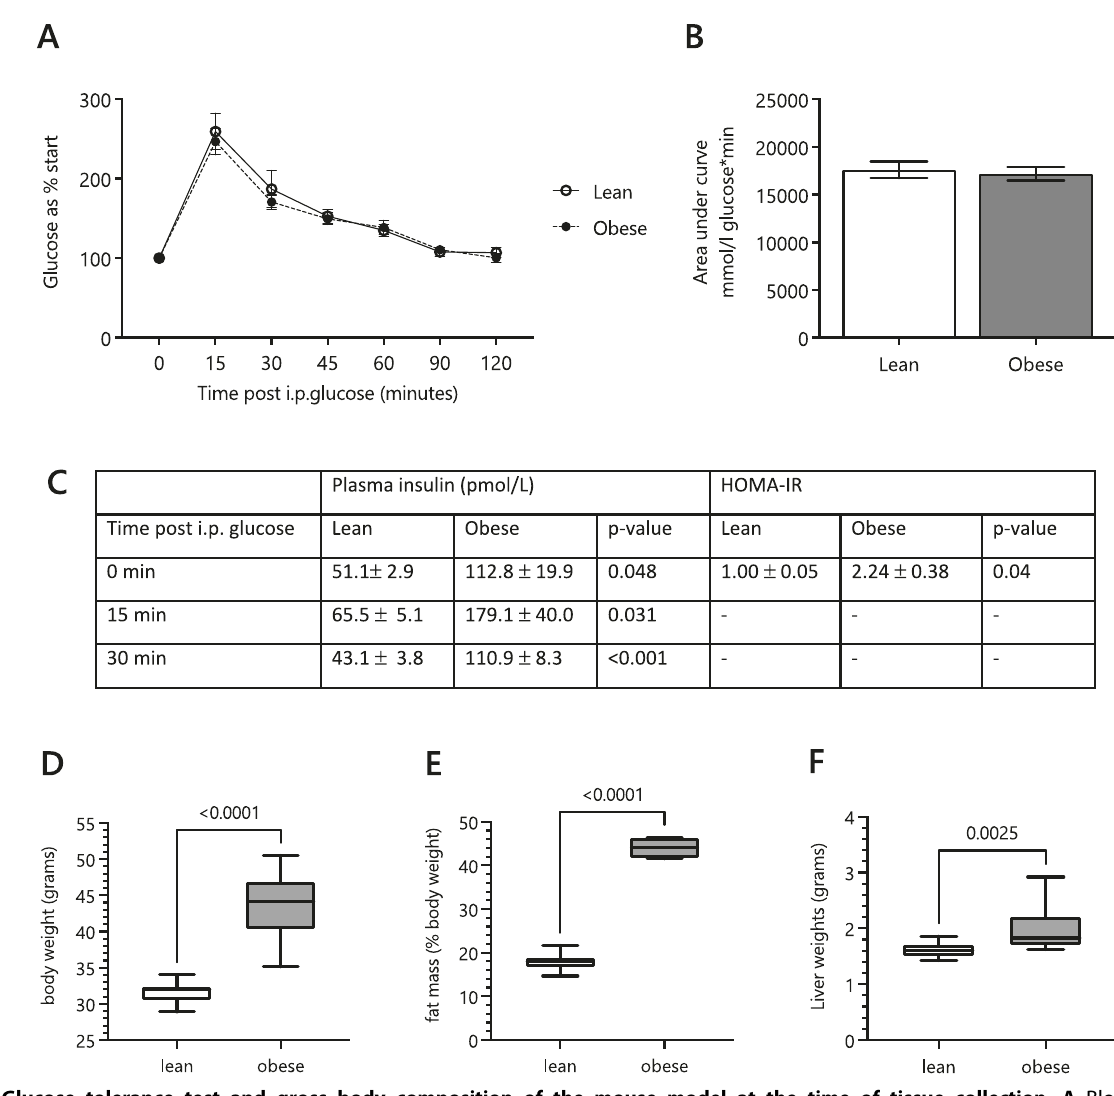
Fig. 2 Glucose tolerance test and gross body composition of the mouse model at the time of tissue collection. A Blood glucose concentrations in post-weaning dams during a glucose tolerance test (GTT). B Glucose area under the curve during the GTT. C Insulin concentrations in dams ’ plasma at basal (0), 15 and 30 min post glucose challenge and calculated fasting HOMA-IR (0 min). D Dam bodyweight at weaning. E Dam fat mass (measured by TDNMR) as a percentage of bodyweight at weaning. F Dam liver mass at weaning. The p values are based on unpaired Student t -tests between the lean and obese groups for comparisons given above braces between distributions. I.P., Intra- peritoneal; HOMA-IR, HOmeostatic Model Assessment for Insulin Resistance.